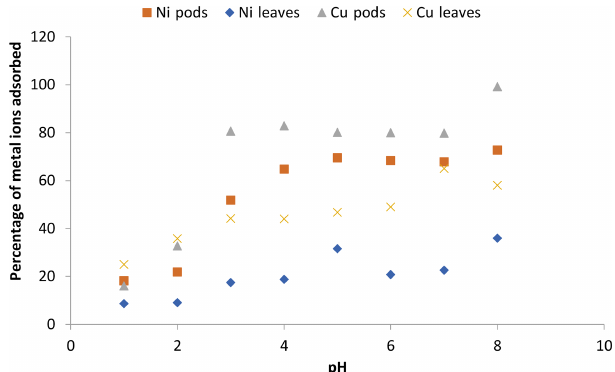
Figure 4. The effect of pH on the adsorption of Ni(II) and Cu(II) by Delonix regia pods and leaves. The experimental conditions were as follows: a pH from 1 to 8, a contact time of 300min, an adsorbent dosage of 0.5 and a metal ion concentration of 100mgL − 1